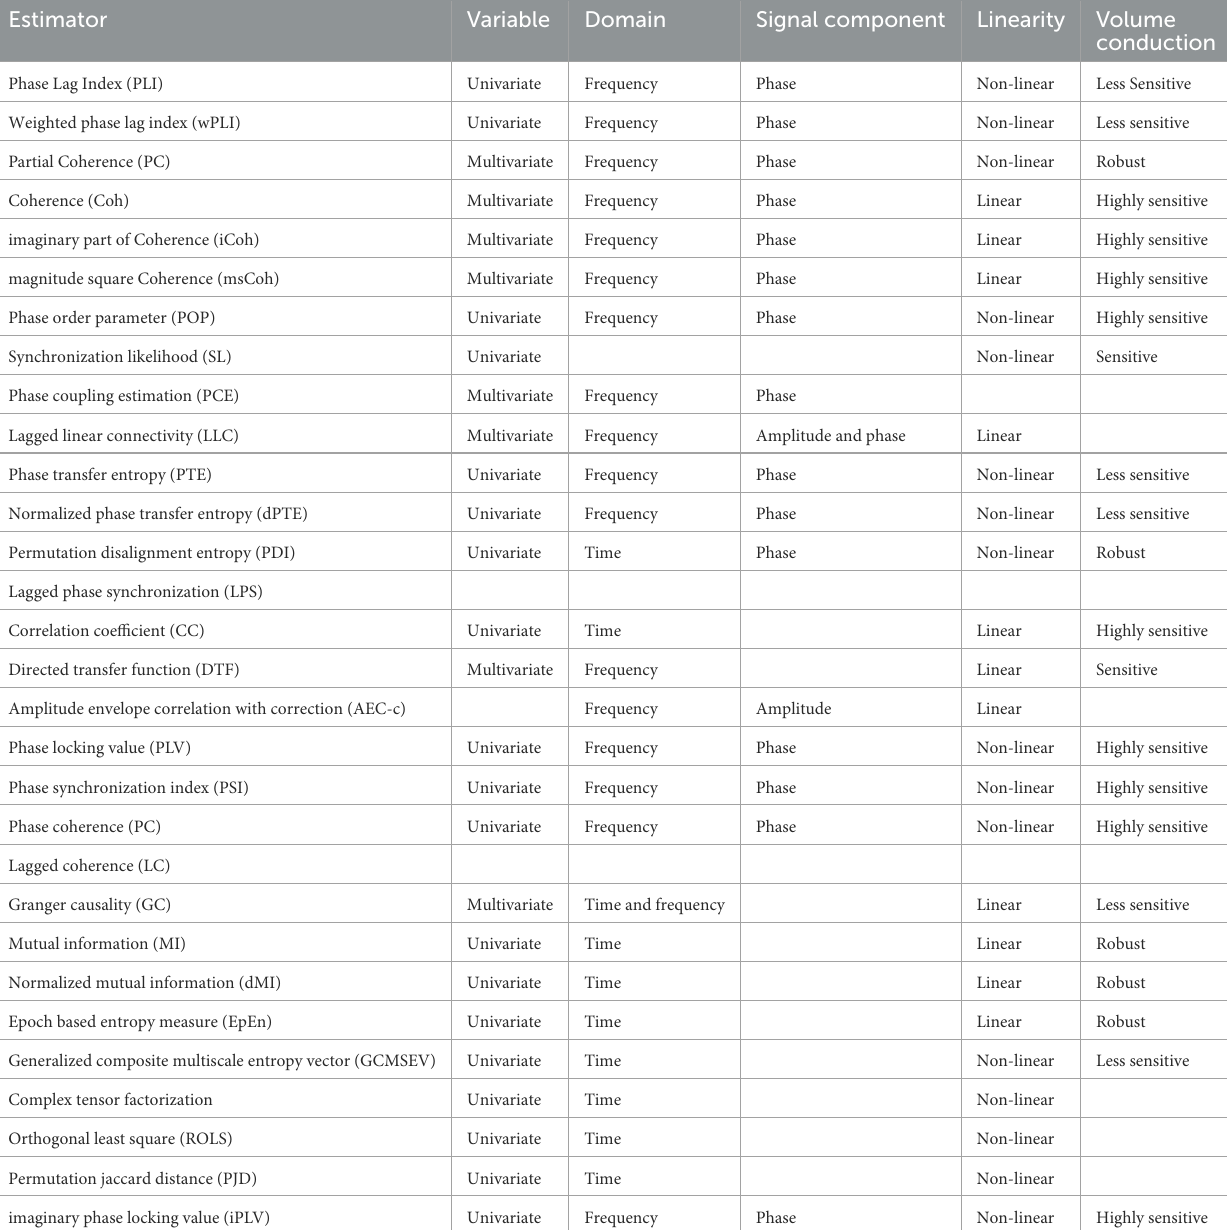
TABLE 2 List of functional and effective connectivity techniques used recently for dementia-related disorder analysis of electrophysiology signals within the last 5 years and their respective